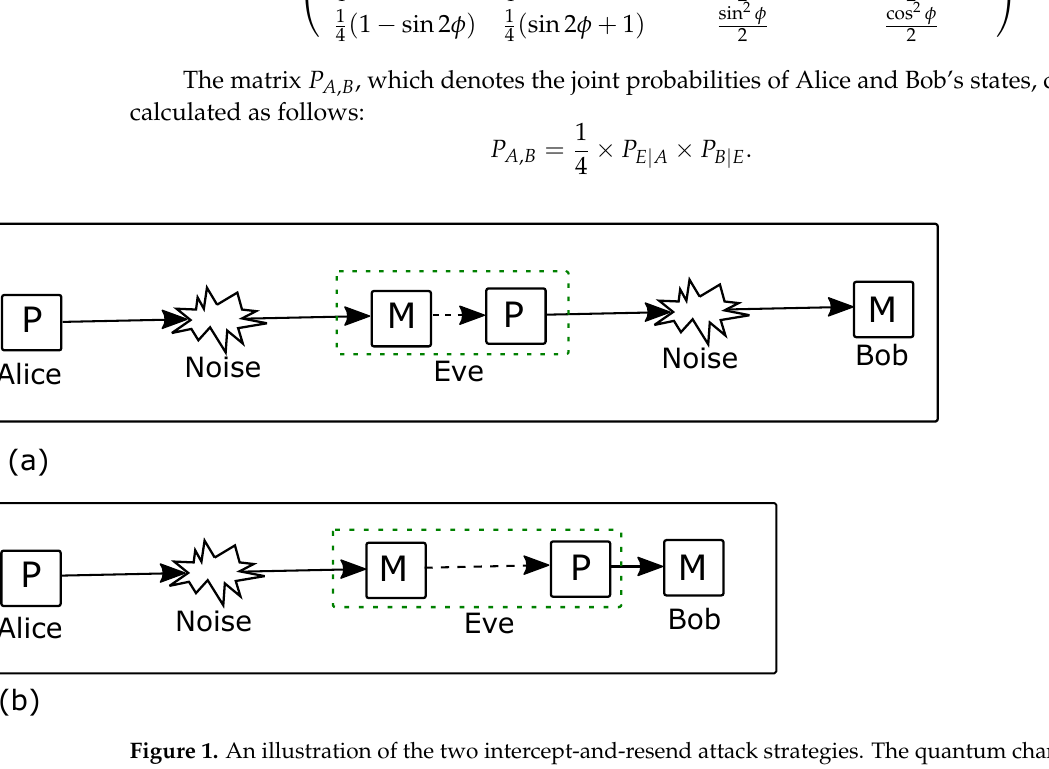
Figure 1. An illustration of the two intercept-and-resend attack strategies. The quantum channel is denoted by straight arrows, while dashed arrows depict lossless classical channels. ( a ) Eve breaks the quantum channel between Alice and Bob and places her devices between the two parties. ( b ) Eve places her preparation device at a location close to, possibly inside, Bob’s lab and connects her measurement and preparation devices by a lossless classical channel. The letters P and M represent preparation and measurement devices,